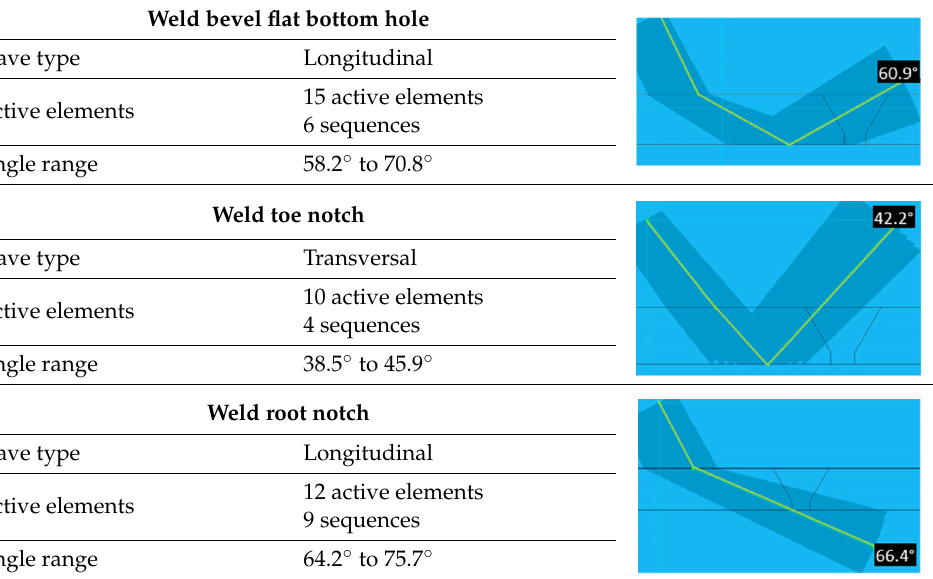
Table 4. Characteristics and beam coverage representation of each focal law. Weld bevel flat bottom hole